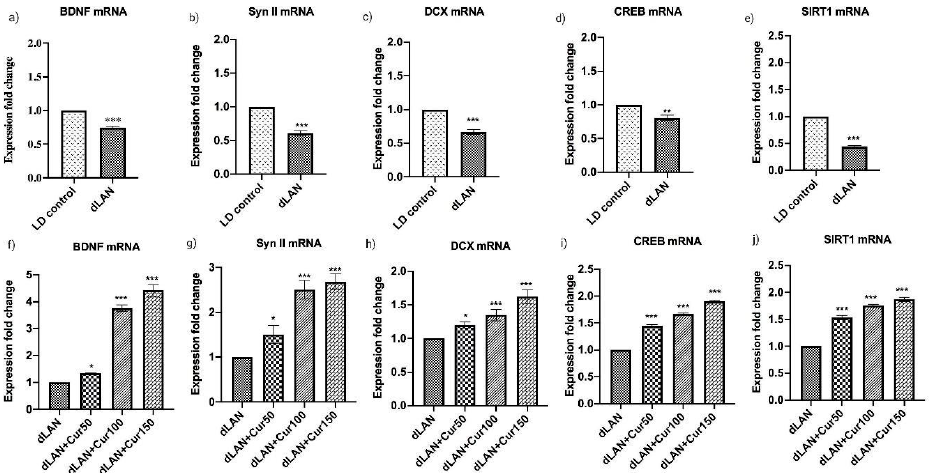
Figure 5. Effect of curcumin on dLAN altered hippocampal mRNA ( a , f ) BDNF, ( b , g ) Synapsin II, ( c , h ) DCX, ( d , i ) CREB, and ( e , j ) SIRT1. Values are represented as mean ± standard deviation. The t- test